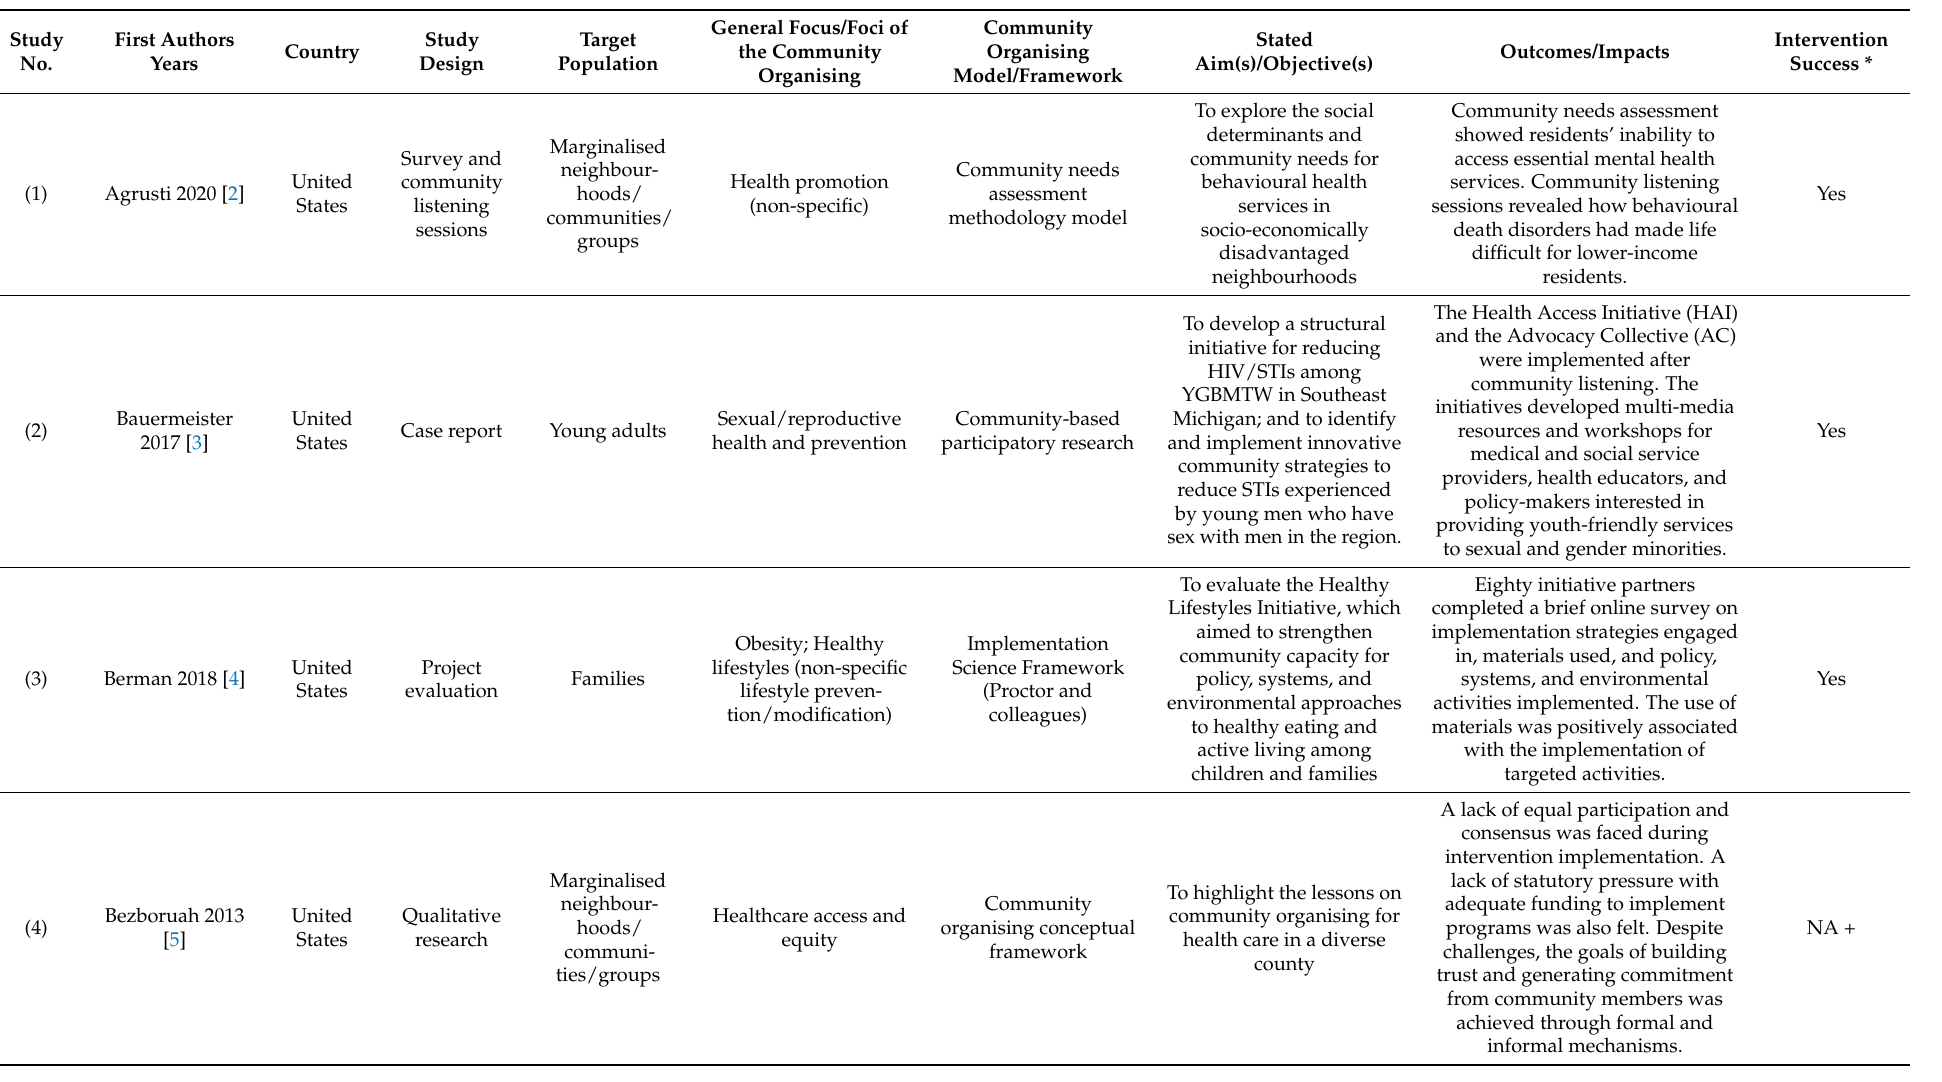
Table 1. Sample characteristics, methods and outcomes of the reviewed studies on community organizing and health (n = 38). Study